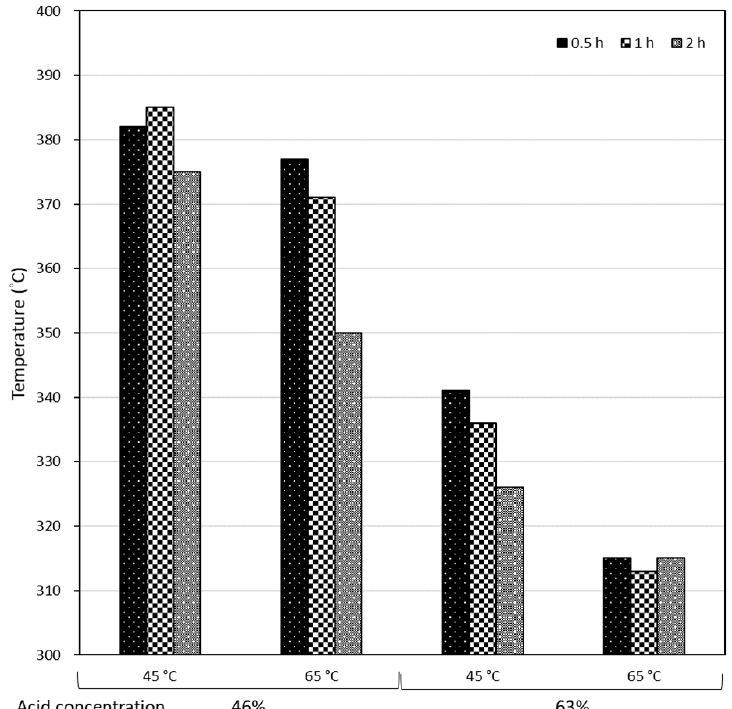
Figure 12. Degradation temperature of P-CNCs prepared in different conditions.